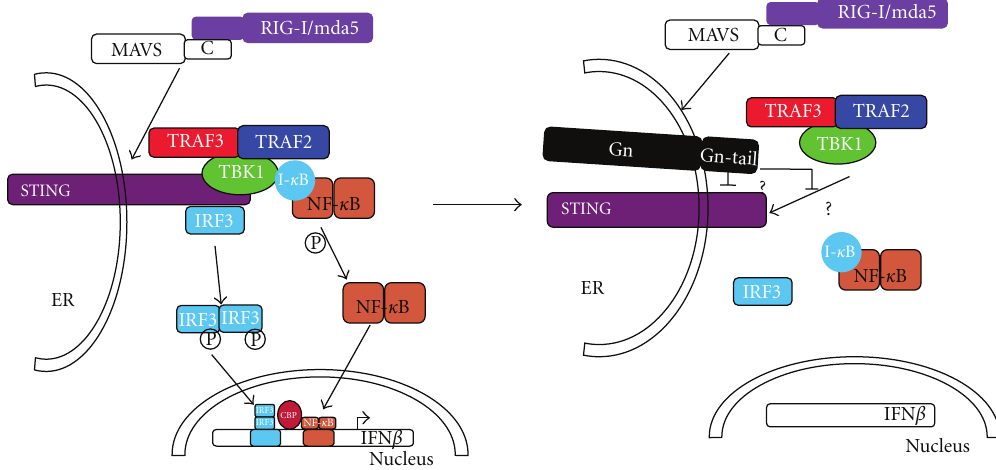
Figure 1: Potential model of hantavirus Gn-T disruption of STING-TBK1-IRF3 complex formation. Normally RIG-I/Mda5 recognition of viral RNA activates mitochondrial MAVS resulting in the downstream activation, phosphorylation, and dimerization of ER-resident STING [59–62, 65, 80]. STING is a sca ff olding protein that binds TBK1 complexes through its C-terminal cytoplasmic domain [60, 61, 65], and STING-recruited TBK1 phosphorylates IRF3 and I κ B. This activates NF- κ B, permits IRF3 dimerization, and results in nuclear translocation of both IRF3 and NF- κ B which are both required for IFN β transcription. Expression of the NY-1V, ANDV, or TULV Gn-T inhibits RIG-I- and TBK1-directed IFN β transcription but has no e ff ect on activated IRF3 [49–51]. Gn-T expression disrupts TBK1 binding to TRAF3 and acts at the level of STING-TBK1 complex formation to inhibit IRF3 and NF- κ B activation [49–51]. The specific interactions of the Gn-T with STING and TBK1 complexes that inhibit downstream pathway activation remain to be